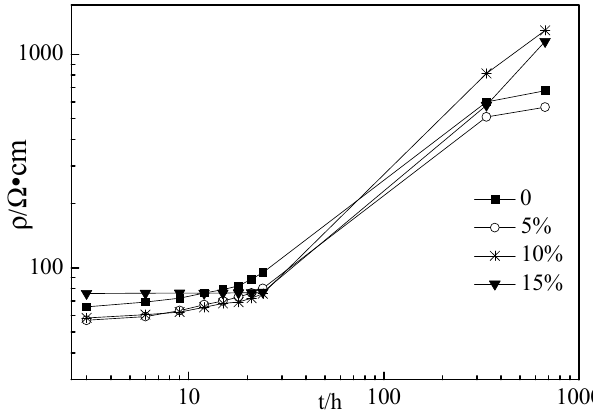
Figure 5. Electrical resistivity of specimens with the w/c ratio of 0.50.